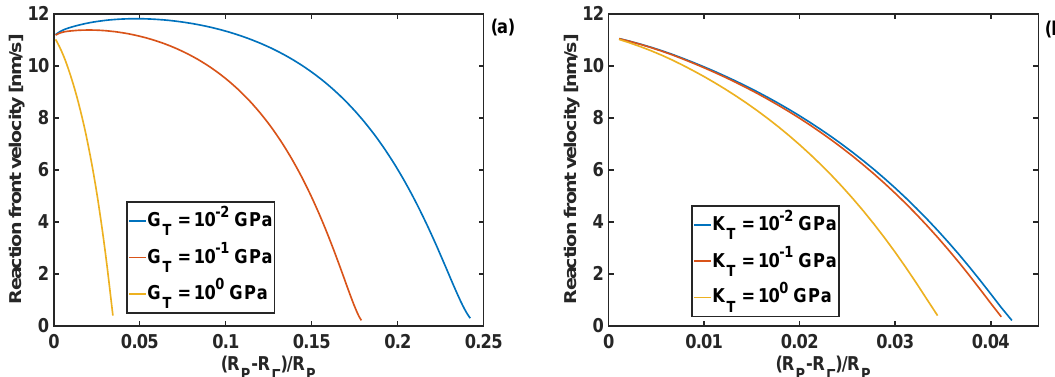
Figure 12: Reaction front velocity profiles of the fully-constrained particle; (a) for different coating shear moduli and coating bulk modulus K T =1 GPa and thickness of h T =10 2 nm; (b) for different coating bulk moduli and coating shear modulus G T =1 GPa and h T =10 2 nm.